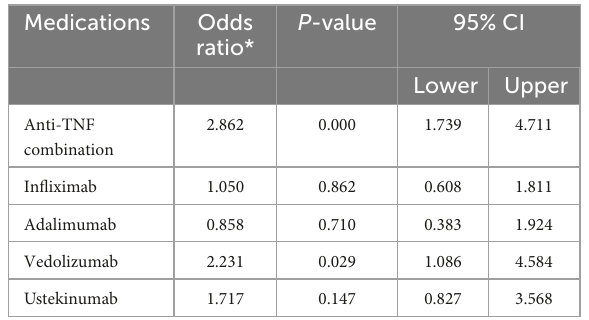
TABLE 3 Association between biologic medications use and being overweight or obese compared to having normal weight in patients with inflammatory bowel disease